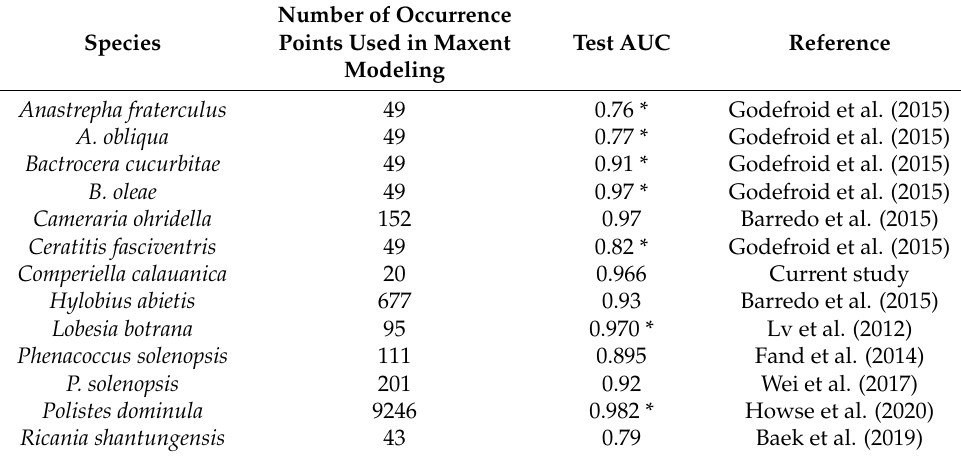
Table 3. Number of occurrence points used for Maxent modeling of selected insect species with respective test AUC